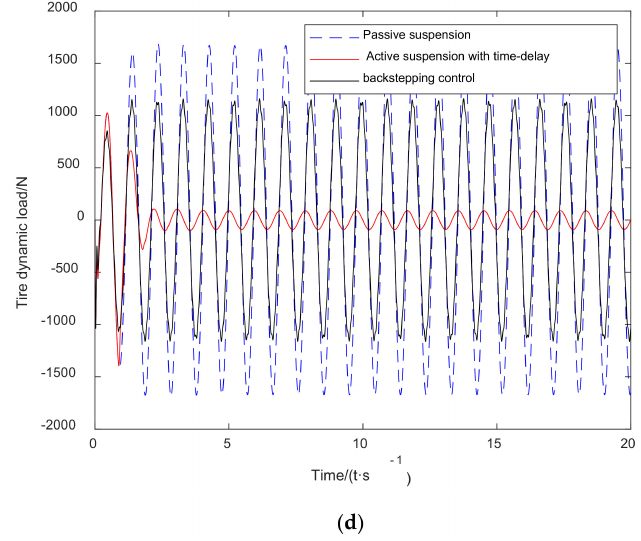
Figure 6. Comparison chart of suspension performance simulation results under harmonic excitation; ( a ) Passenger vertical acceleration comparison chart; ( b ) vehicle body vertical acceleration comparison chart; ( c ) suspension dynamic deflection comparison chart; ( d ) tire dynamic load comparison